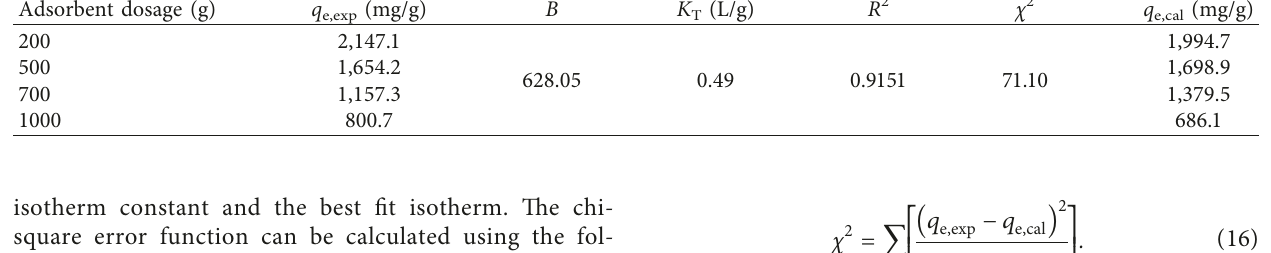
Table 6: Temkin isotherm constants using modified bagasse using a pilot-scale system. Adsorbent dosage